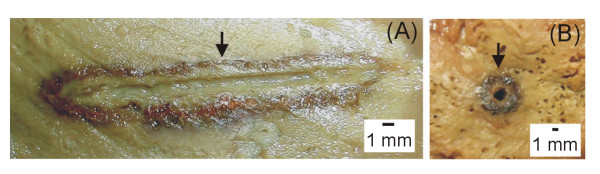
Char ring created by a single internally cooled electrode with an effective area of 3 cm in length. Longitudinal (A) and cross section (B) of the coagulation obtained by a single 3 cm exposed tip internally cooled electrode at 1800 mA (maximum current) for 10 minutes without using either saline perfusion into the tissue or an impedance control algorithm (unpublished personal experiments in bovine liver ex vivo). A ring of char tissue surrounding the electrode track is clearly shown (arrows).